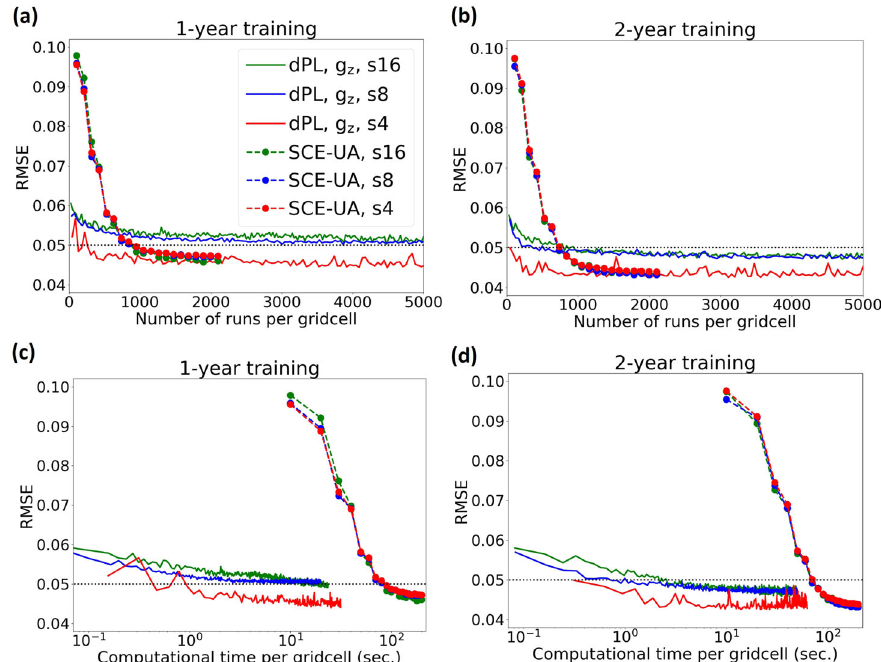
Fig. 2 Objective function (root-mean-square error, RMSE) and computational time for the testing period vs. number of forward runs per gridcell. Here, a forward run for dPL means running through the same number of days as the speci fi ed training period, e.g., 30 random instances of 240-day-long simulations in a minibatch would be counted as ~20 runs for a 2-year training period. Dashed lines are for SCE-UA and solid lines are for dPL. s16, s8, and s4 denote models trained with sampling densities of 1/16 2 , 1/8 2 , and 1/4 2 , respectively, where 1/16 2 represents sampling one gridcell from each 16 × 16 patch. The dotted horizontal line represents the RMSE threshold of 0.05, below which a model is considered functional. a RMSE for the models trained with 1 year ’ s worth of data. b Same as a but for models trained with 2 years ’ worth of data. c RMSE vs computational time per gridcell. Both methods use the same surrogate model running on one GPU, and 1 year ’ s worth of training data. d Same as c but for models trained with 2 years ’ worth of